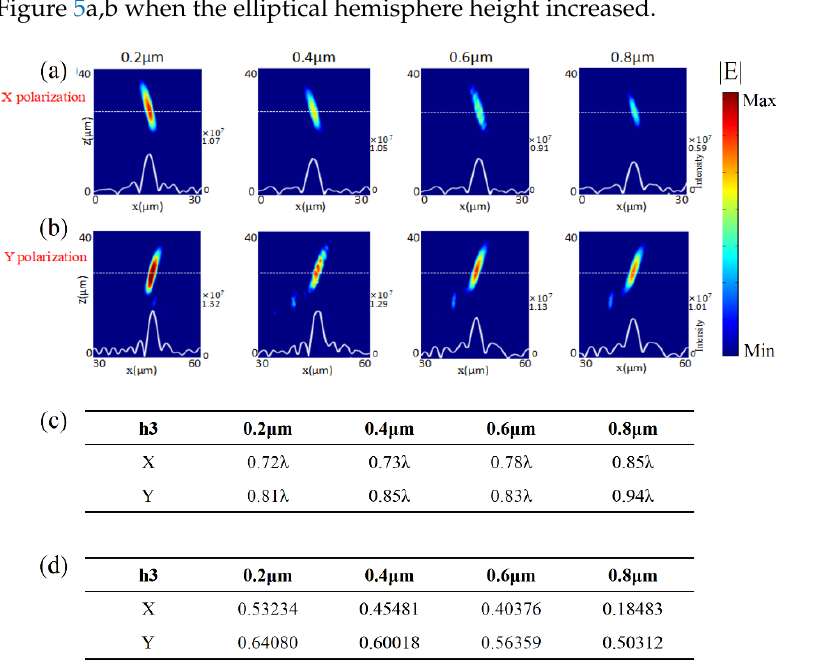
Figure 6. The Focusing efficiency of GaAs nano-bricks with ( a ) different height ( h 1 ), ( b ) inclination angle ( θ ) and ( c ) elliptic hemisphere height ( h 3 ) under x - and y -polarizations.